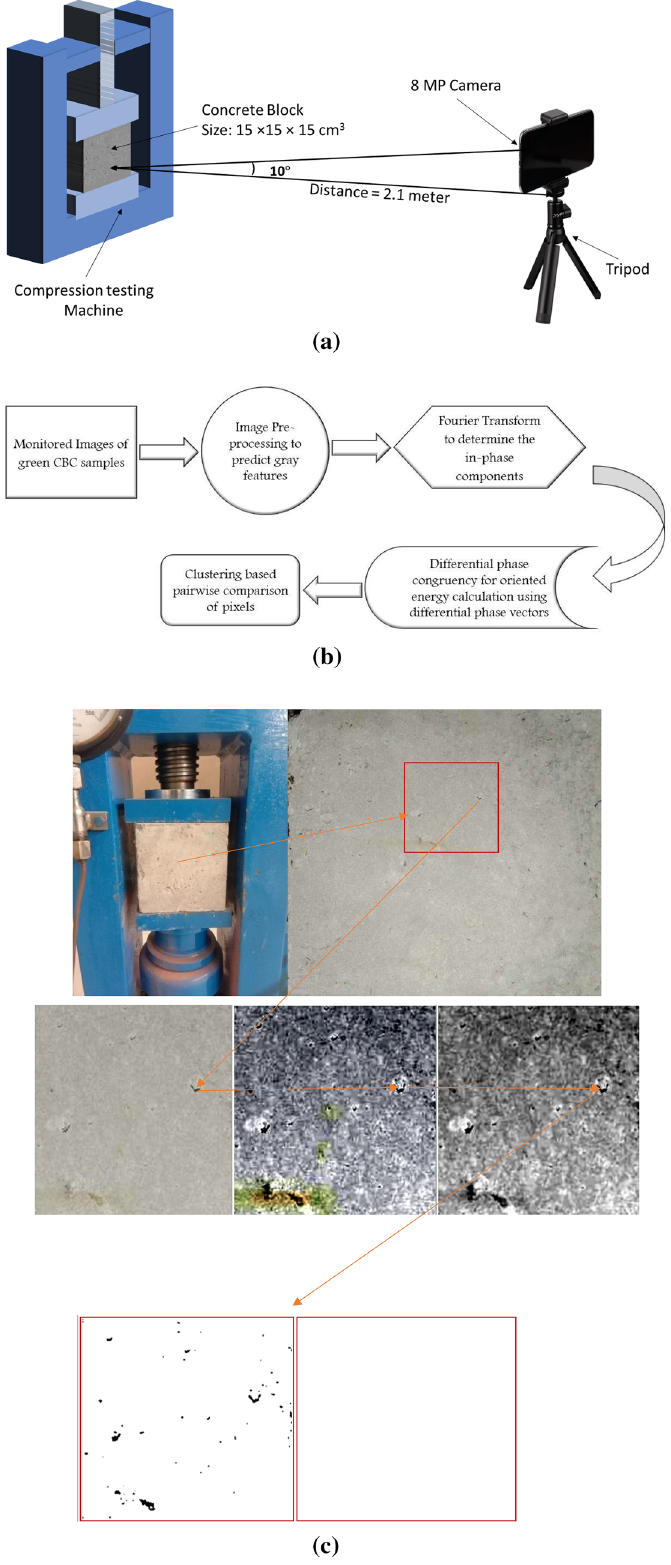
Figure 7. ( a ) Schematic diagram showing experimental arrangement. ( b ) Flowchart showing broad steps of spectral clustering algorithm for crack detection. ( c ) Steps followed by image processing algorithm and removal of